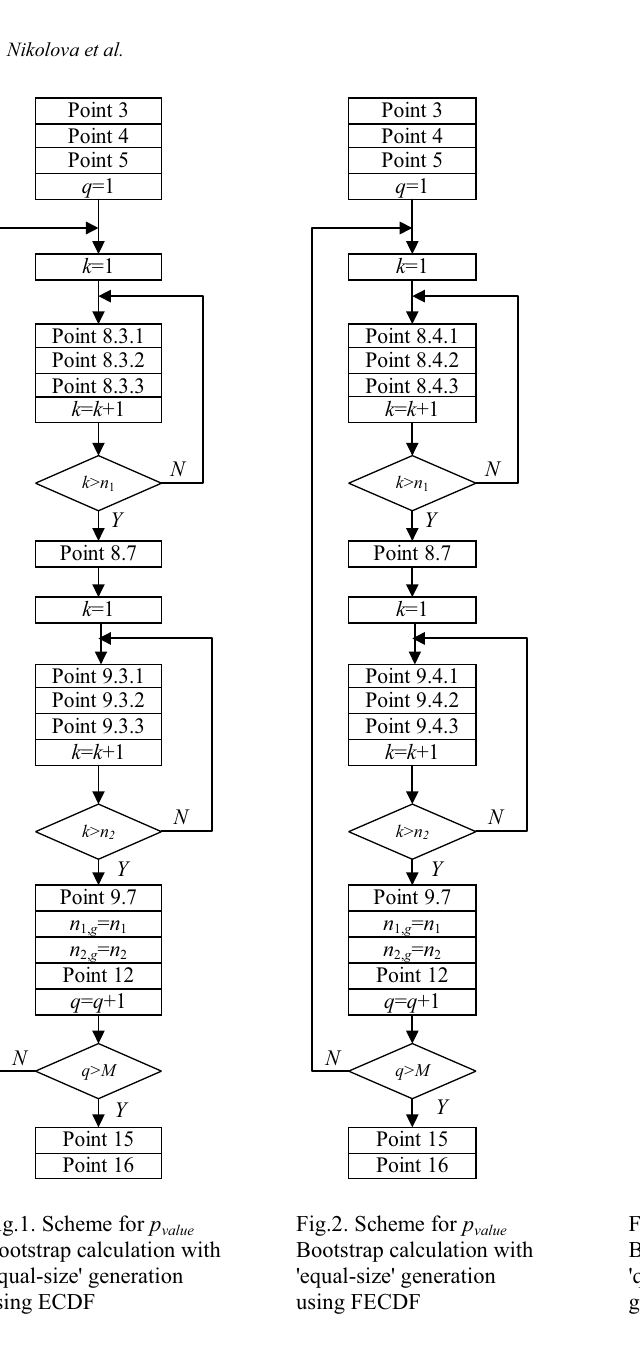
Fig.2. Scheme for p value Bootstrap calculation with